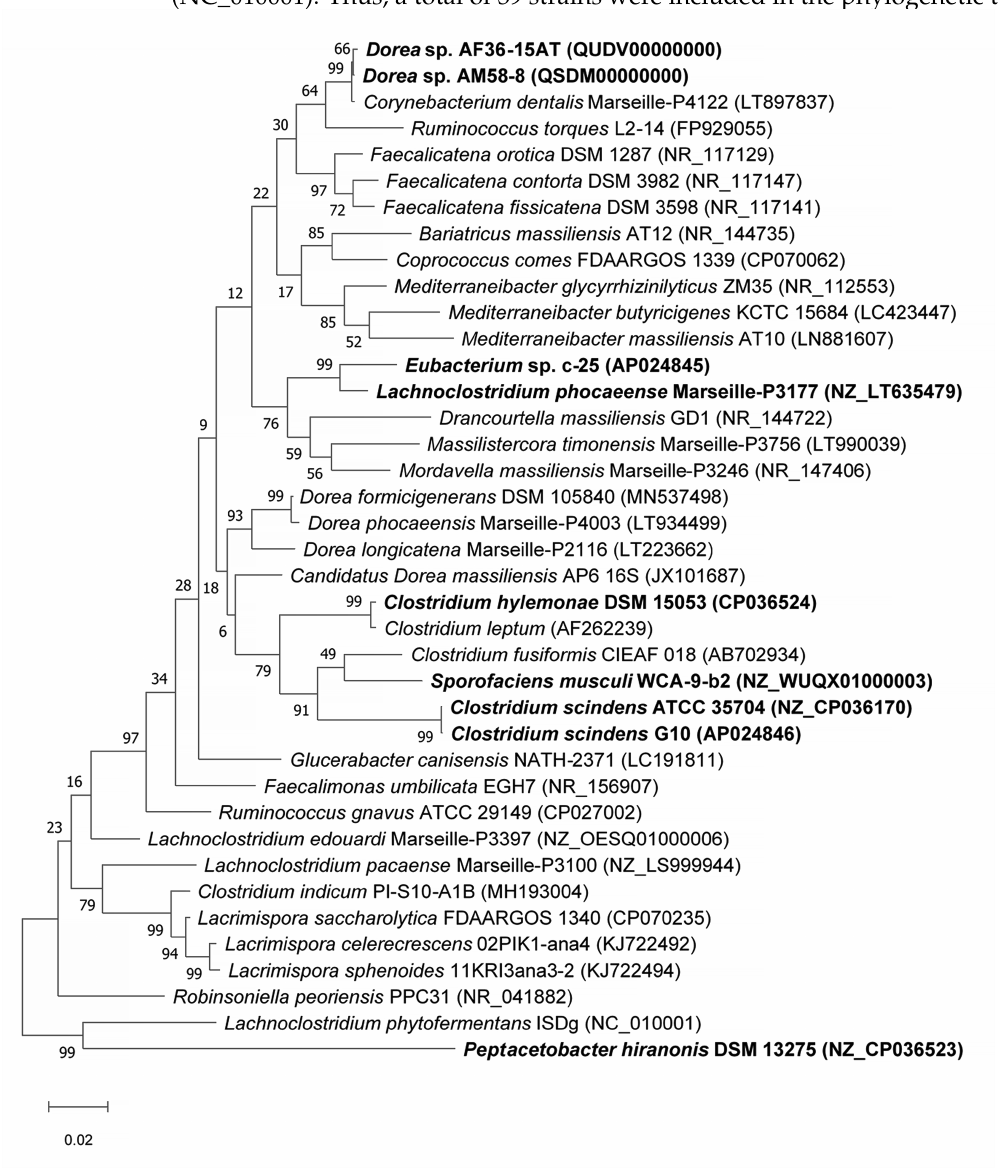
Figure 5. Maximum Likelihood phylogenetic tree of Eubacterium sp. c-25 and related species of the intestinal bacteria including known DCA producers. Strains included in the tree construction consisted of the 29 closest 16S rDNA